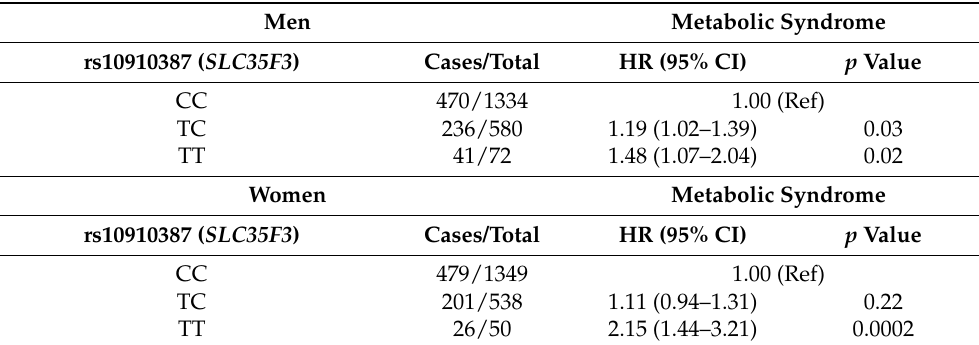
Table 4. Adjusted hazard ratios (HRs) and 95% confidence intervals (CIs) of metabolic syndrome incidence depending on the genotype of SLC35F3 rs10910387.